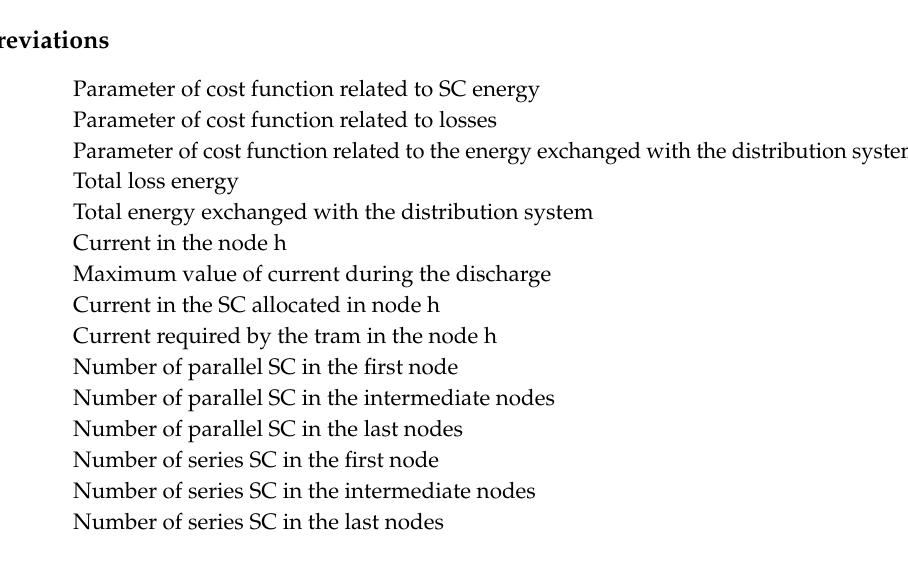
Figure 12. Current trend in the node 10 during the movement of the tram along the track.